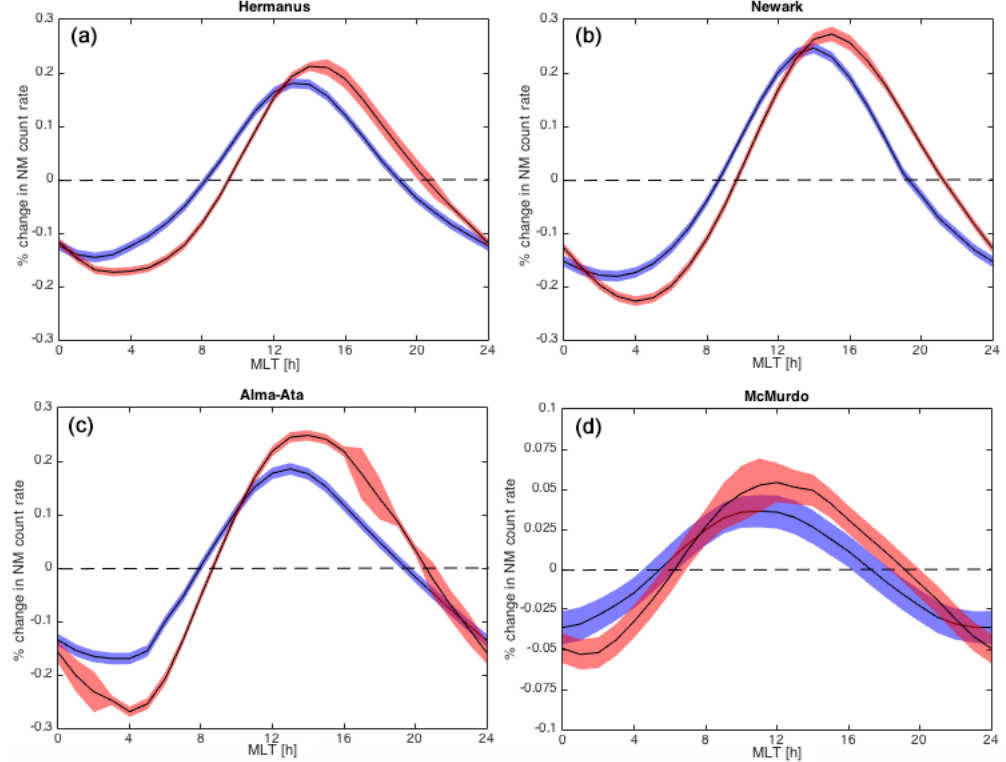
Figure 4. Mean diurnal variations of neutron monitor count rates from Hermanus, South Africa (a) , Newark, USA (b) , Alma-Ata, Kazakhstan (c) , and McMurdo, Antarctica (d) . All times where the near-Earth heliospheric magnetic field strength has surpassed 10nT have been removed, including 3 days of data afterwards to remove DV trains following solar wind transients. The data are split by the dominant solar polarity where A< 0 cycles are shown in red and A> 0 cycles are shown in